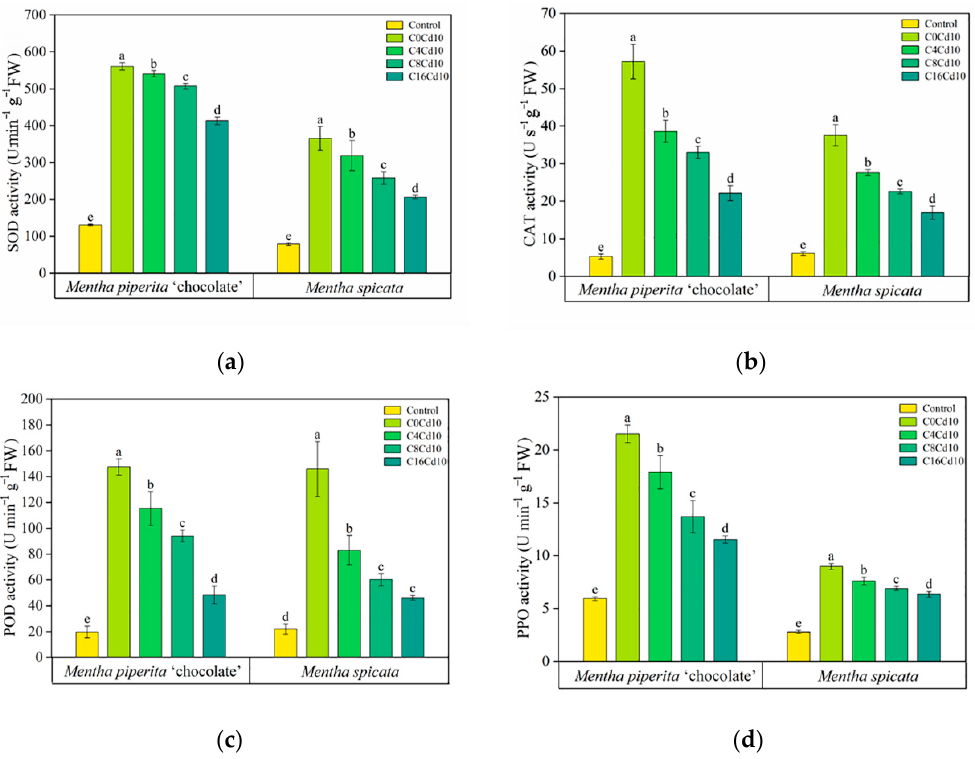
Figure 3. Effect of biochar on SOD activity ( a ), CAT activity ( b ), POD activity ( c ), and PPO activity ( d ) of two mint species under Cd stress. The error line is the standard deviation of the mean (n = 3) and different letters indicate significantly different values between treatments for the same plant, p < 0.05. FW, fresh weight.